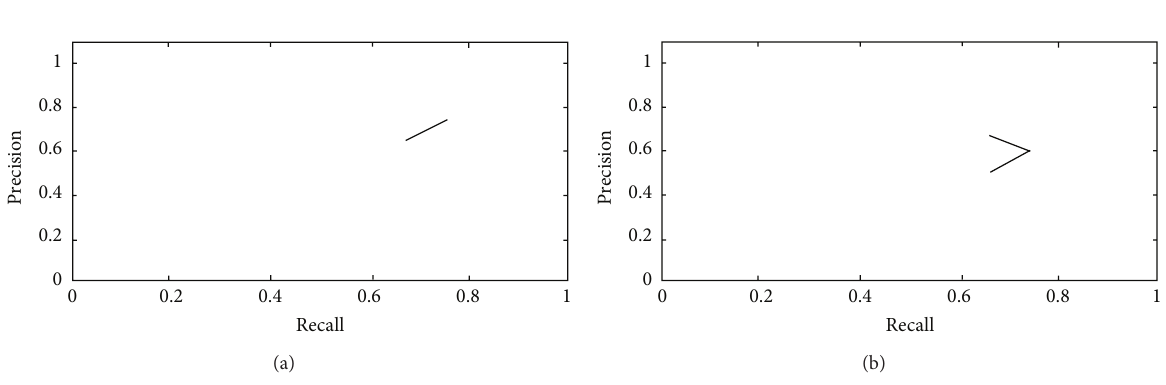
Figure 9: The evaluation of performance (a) for Exact Copy patterns and (b) for Modified Copy